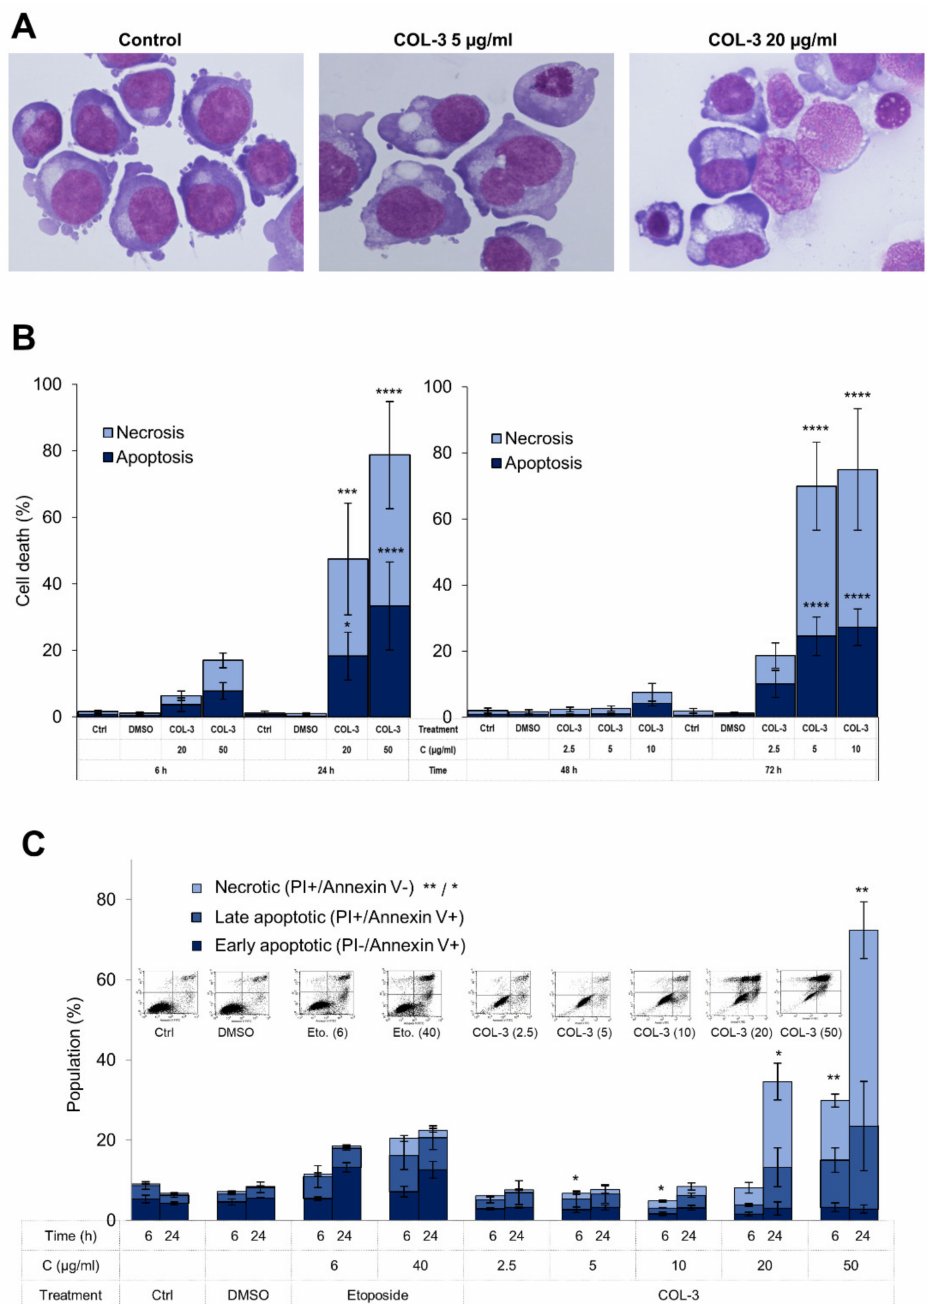
Figure 2. COL-3-induced cytotoxicity in K562 cells. K562 cells were treated with COL-3 (C, 2.5–50 µ g/mL) for 72 h. May–Grünwald-stained cells with morphological features of apoptosis (chromatin condensation) and necrosis (increased cell size and cytoplasmic vacuolization) ( A ) were counted as a percentage of 400 cells per slide ( B ). ( C ) The cells were also stained with Annexin V and PI and subsequently analyzed by flow cytometry. Necrotic cells were designated as PI+/Annexin V − cells, whereas PI − /Annexin V+ cells and PI+/Annexin V+ cells were considered as early and late apoptotic cells, respectively. In ( B , C ), cells treated with etoposide (E, 40 µ g/mL) were used as the positive controls, while vehicle DMSO (D)-treated and/or untreated cells were employed as normal controls. Representative flow cytometry images for treatments after 24 h are shown in the upper part of Figure 2C. Results are expressed as the mean ± SD of three independent experiments. *: p < 0.05; **: p < 0.01; ***: p < 0.001, and ****: p <